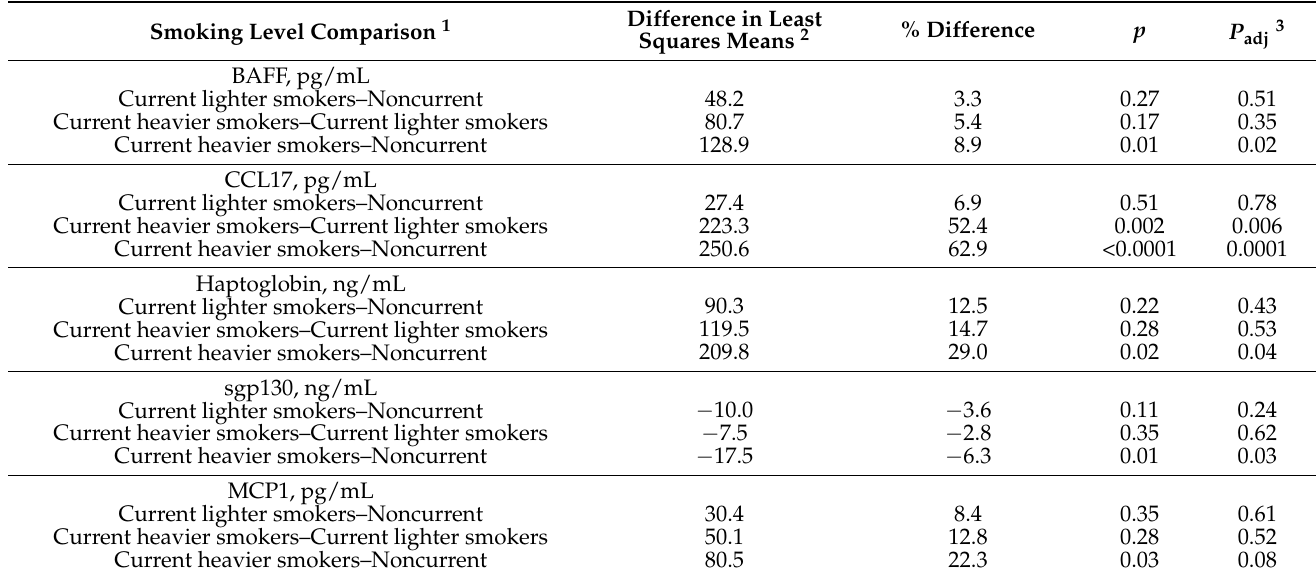
Figure 1. Associations between serum cotinine and each individual immune-related biomarker ( N = 27). Cotinine levels (ng/mL) are defined as noncurrent ( ≤ 3.08) and current (>3.08). Dots represent p values from mixed models assessing cotinine (> vs. ≤ 3.08) and individual biomarker separately. Red dashed line represents p = 0.05. Table 2. Differences in immune biomarker levels by smoking amount defined by serum cotinine